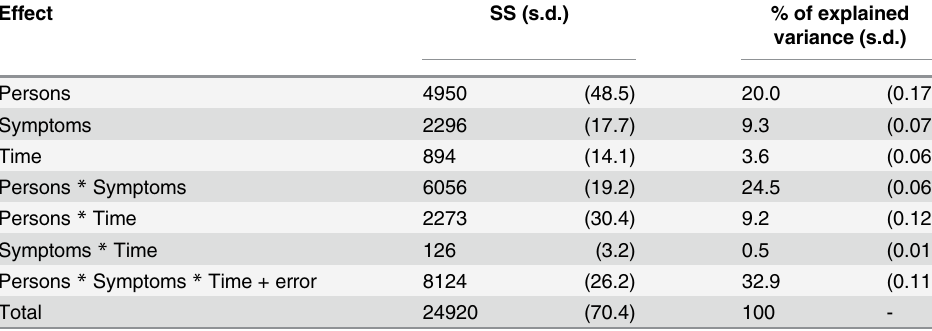
Table 1. Three-way Analysis of Variance after subtraction of the grand mean, with the patient-, symp- tom- and time-components as fixed factors. Note. SS = Sum of Squares. All effects and standard devia- tions (s.d.) averaged across 20 imputed